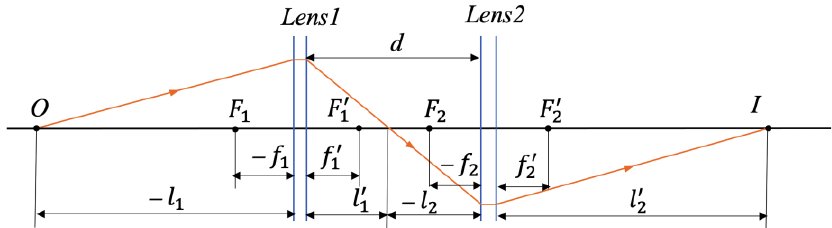
Figure 2. Optical path of a double lenses system .